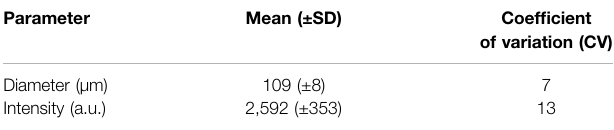
TABLE 2 | Measurement results for the fi ve p-jet spot: mean spots diameter, average SERS intensity, and coef fi cient of variation